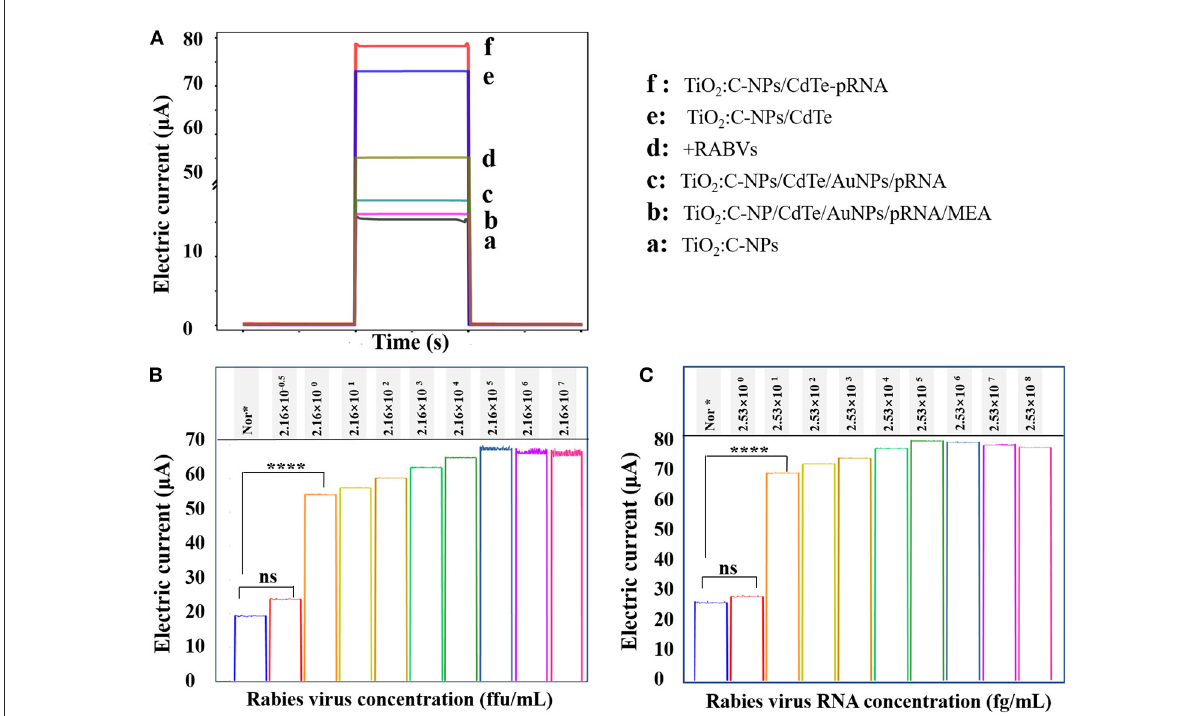
FIGURE3 Corresponding photocurrent response of the electrode. (A) Corresponding photocurrent response of the electrode: (a) TiO 2 :C-NPs, (b) TiO 2 :C-NP/CdTe/AuNPs/pRNA/MEA, (c) TiO 2 :C-NPs/CdTe/AuNPs/pRNA, (d) + RABVs, (e) TiO 2 :C-NPs/CdTe, and (f) TiO 2 :C-NPs/CdTe-pRNA. Photocurrent response of different concentrations of (B) RABV virual particle and (C) RNA in cell lysates, each sample was measured five times.